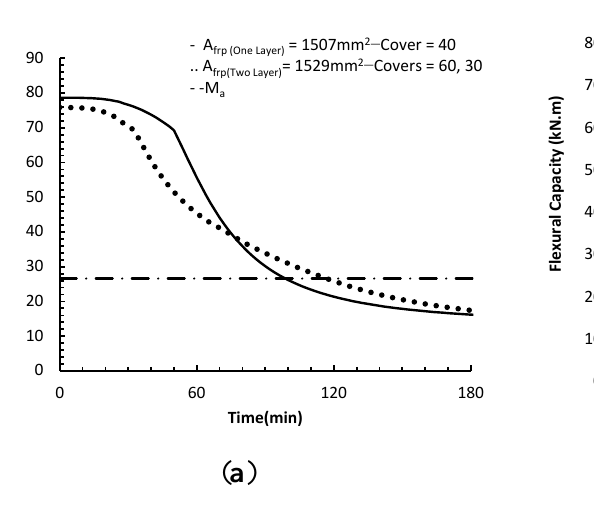
Figure 12. Comparison of flexural capacities of one-layer slab (180 mm) with two-layer with the same area of reinforcement for three cover